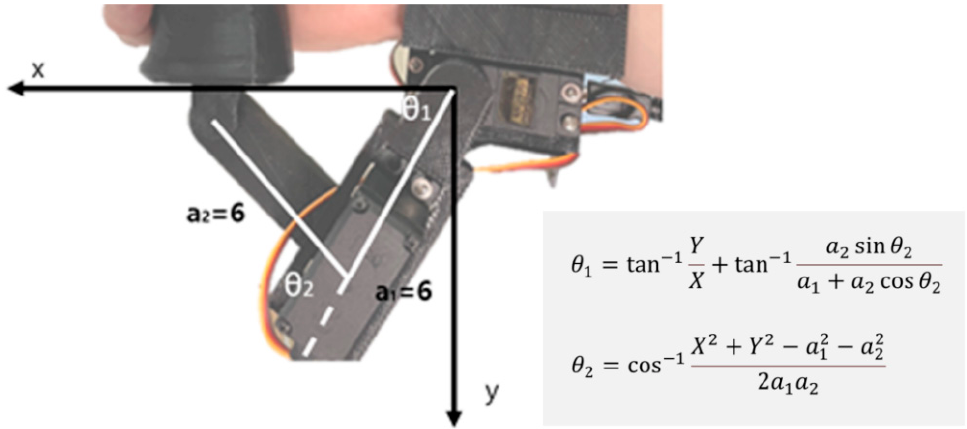
Figure 3. The lower part of the device in the Cartesian co-ordinate plane was used to determine the default position of the device.